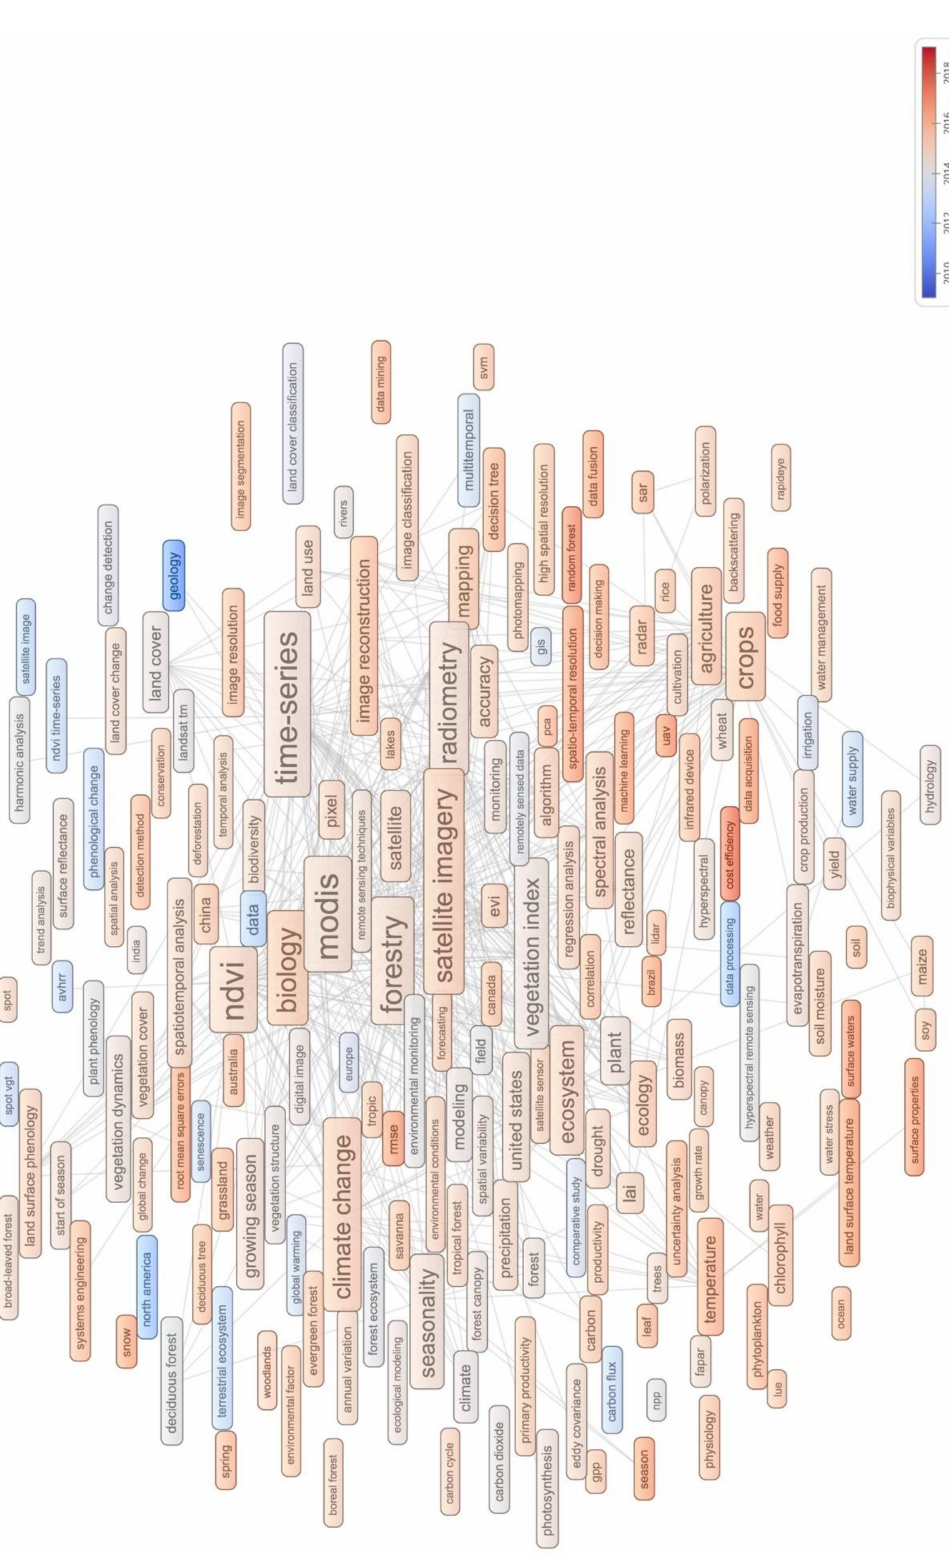
Figure 4. Network mapping of the keywords most used (occurrence threshold = 20) in the rs + pheno research in 2009–2018. Color bar indicates the year in which each keyword was mainly used. Lines represent the link strength between two terms (minimum link strength =